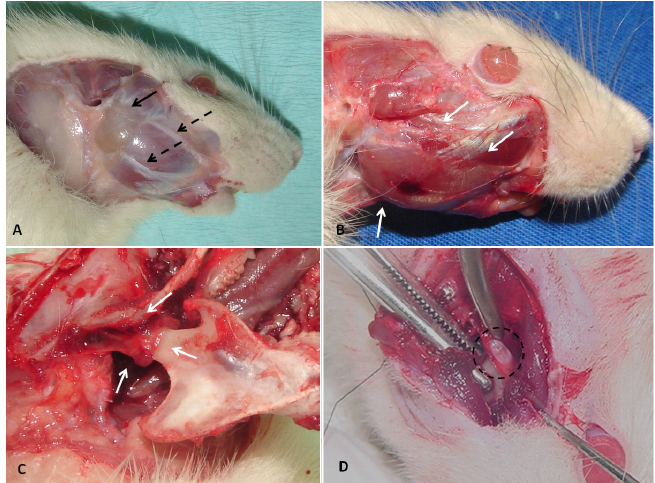
FIGURE 1 - Macroscopical evaluation of the soft tissue. A. Parotid gland (black arrow) and facial nerve (traced black arrow). B. Masseter muscle. C. TMJ capsule. D. Articular disc